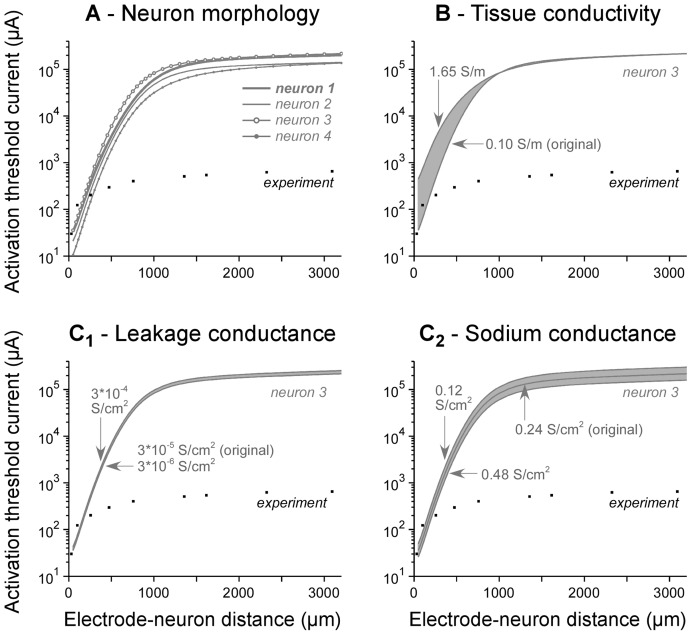
Influence of model parameters on modeling thresholds. A: Different morphologies were considered, from the most complex one (model neuron 1) to the simplest straight fiber (model neuron 4, see Figure 2B). The resulting TC-distance curves were not substantially altered by the choice of the morphology. B: Increasing the conductivity of the neural tissue to that of the aCSF (1.65 S/m) increased TCs for short electrode-neuron distances only (below about 1 mm). C. Increasing or decreasing the leakage conductance by one order of magnitude only altered the amplitude of the TCs by a factor comprised between −4% and +18.5% (C1). Finally, increasing or decreasing the maximum sodium conductance by a factor of 2 only altered the amplitude of the TCs by a factor comprised between −27.5% and +40% (C2). Overall, modifying any of these model parameters did not change TC values down to levels comparable to experimental ones at large distances (over 1 mm).